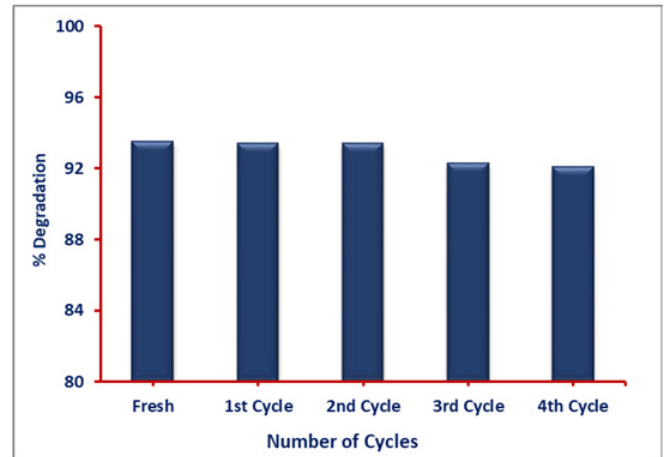
Fig. 14. Recyclability study for photocatalytic degradation of Nigrosine dye.